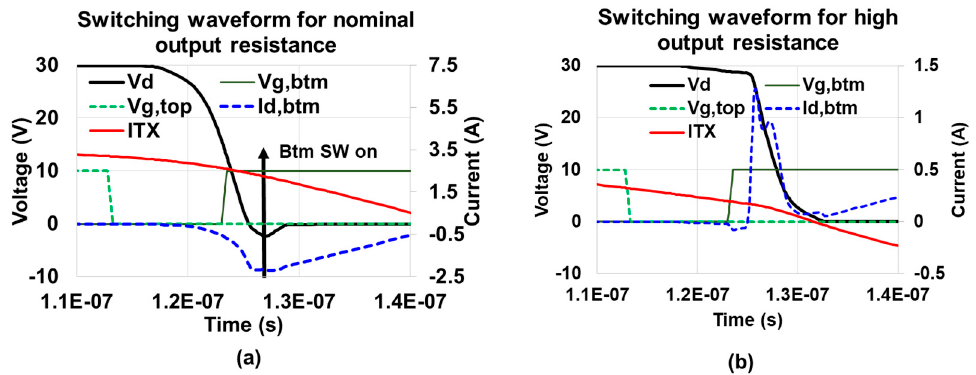
Figure 2. ( a ) Typical normal waveforms when the inverter is in zero-voltage switch mode. ( b ) When Tx and Rx are close together with high coupling. Zero-voltage switching fails due to excessive reflected resistance.